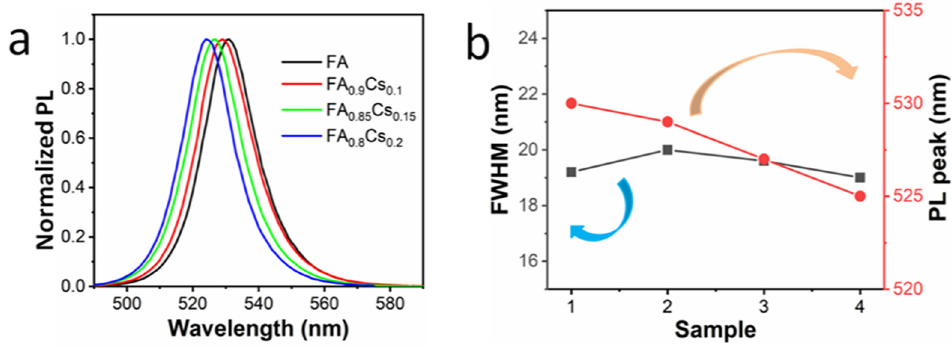
Figure 3. ( a ) PL spectra and ( b ) FWHM and PL peak changes in different perovskite